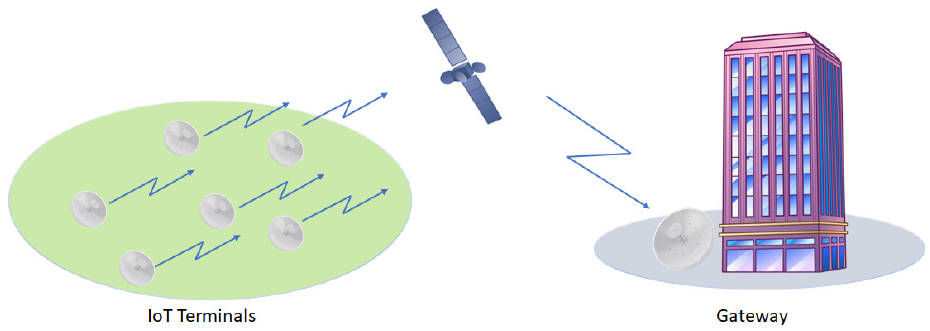
Figure 1. MASSIVE system scenario overview.